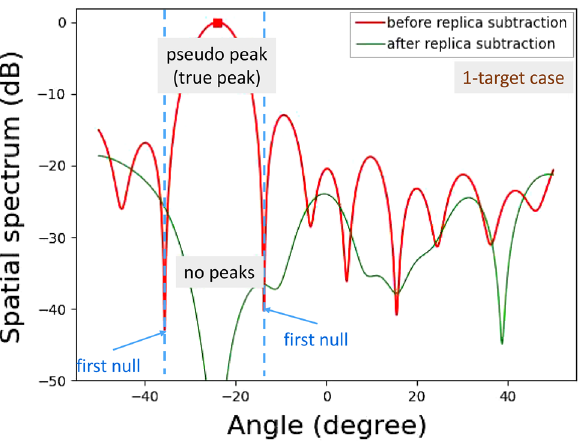
Figure 22. Demonstration results for vertical angle estimations of on-road obstacles: 1-target case.